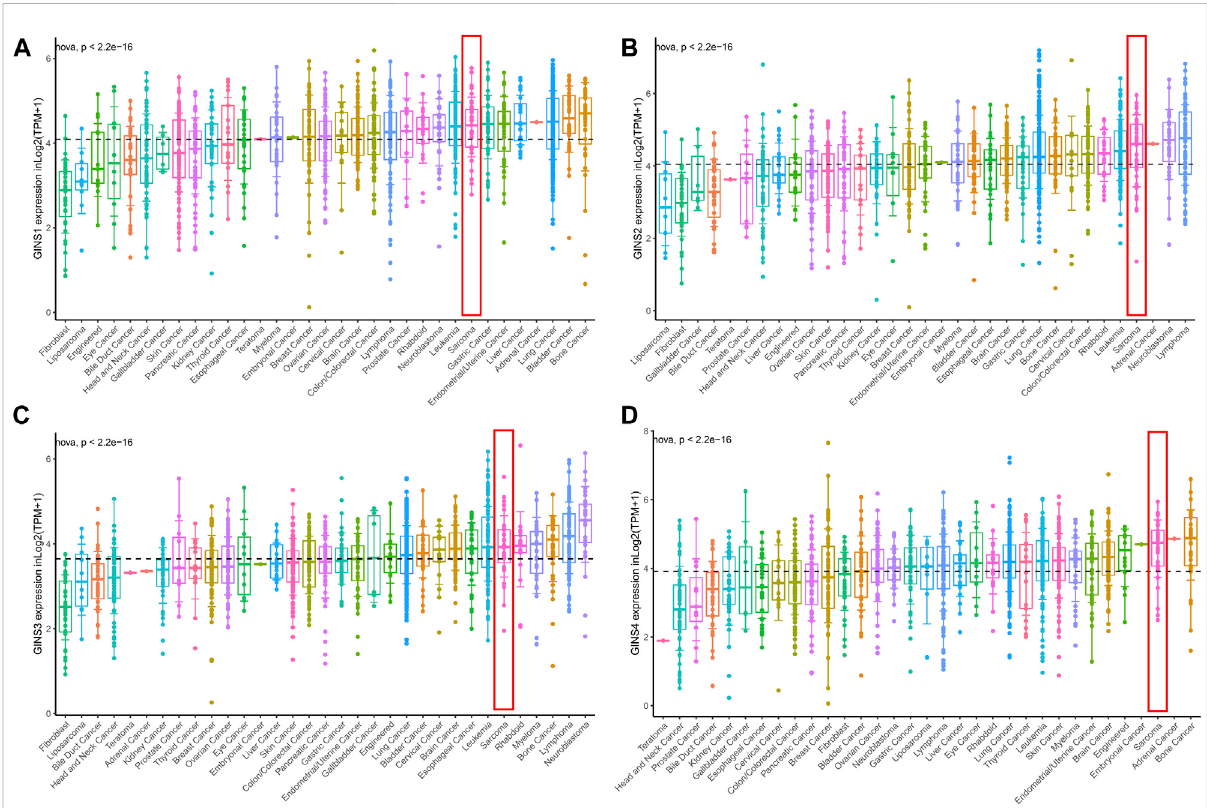
FIGURE 4 ThemRNAexpressionlevelofGINSsubunitsincancercelllinesfromtheCCLEdatabase.TheexpressionofGINS1/2/3/4inSARCrankedeighth, fourth, sixth, and third among various cancer cell lines (A – D)